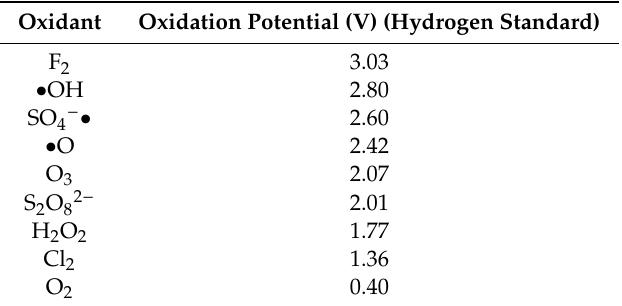
Table 1. Standard electrode potentials of common oxidants